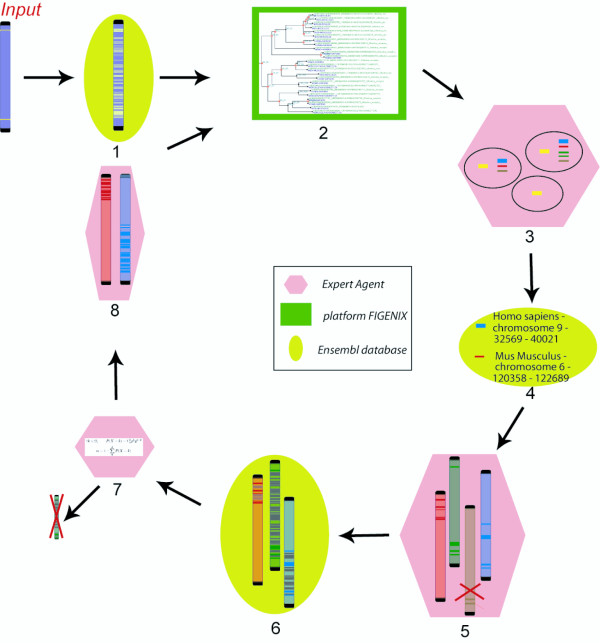
The diagram depicts how processes and agents are overlaid. Agents are pink, green and yellow, as represented in Fig 1. Arrows represent communication channels between the expert system and the other agents. The persistence agent is not represented as it is used throughout the process: (input). The user gives the two boundary genes of the target region - (1) The region is completed by all genes present in the Ensembl database - (2) The phylogenetic tree is computed for each gene - (3) Orthologous genes are calculated (forester) - (4) Each orthologous gene is located on the chromosome in its species - (5) Orthologous genes are clusterized if they are in the same chromosome and the same species. If the cluster contains fewer than three genes, it is removed - (6) Clusters are completed with genes contained in the region and that are not orthologous genes - (7) A score is calculated for each cluster: if the conserved site is not significant, then the cluster is removed - (8) The system restarts with new regions.